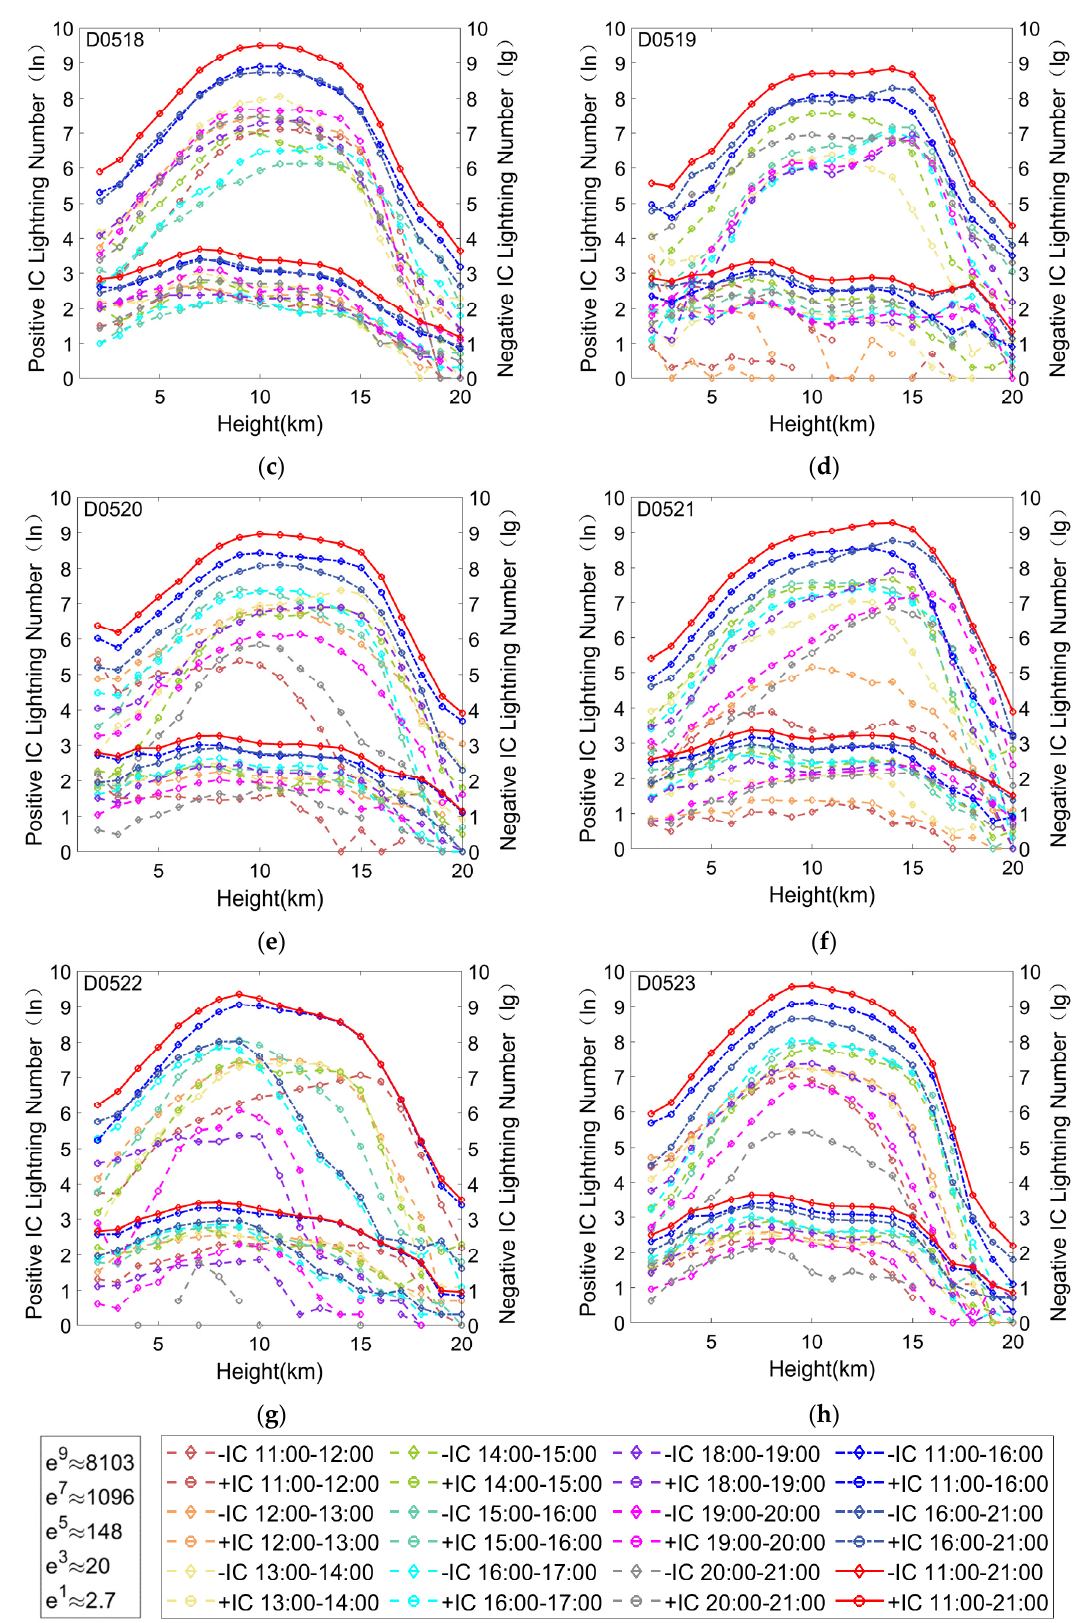
Figure 6. The number of IC events with the height in various time intervals: ( a – h ) The number of positive IC events is processed by the natural logarithm (the left y -axis), while the number of negative IC events is processed by the denary logarithm (the right y -axis). Lines marked with circles belong to the positive events, and lines marked with diamonds represent the negative events. The